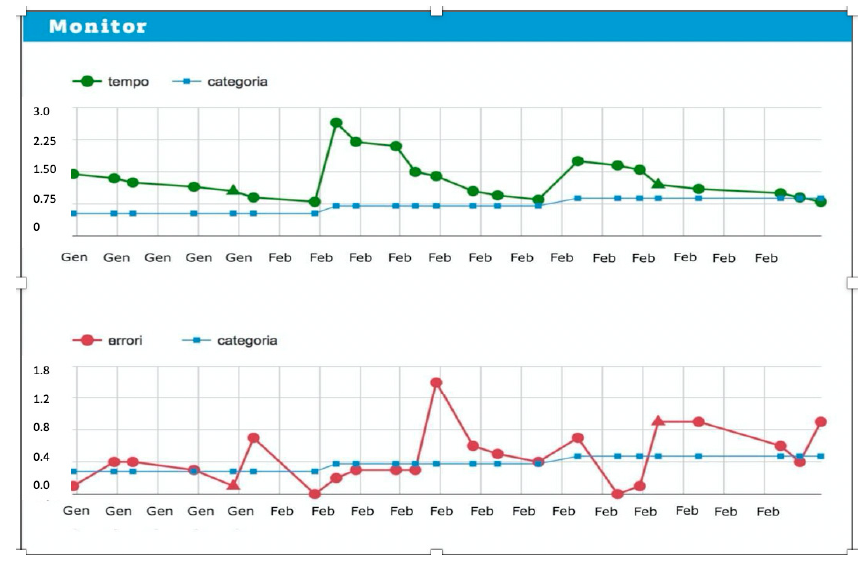
Figure 2. Example of monitoring